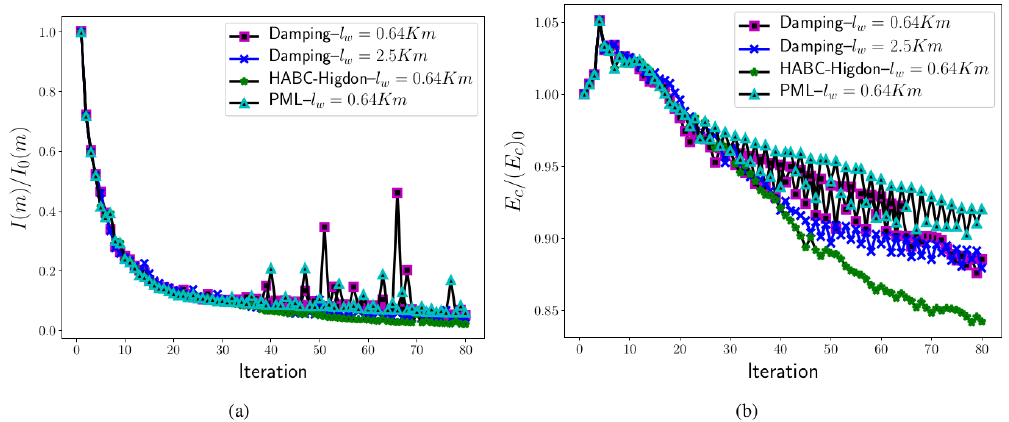
Figure 15. Comparisons of the misfit values I(m)/I 0 (m) (a) and of the velocity model errors E c /(E c ) 0 (b) for a velocity model computation that is then matched with Marmousi, where I 0 (m) and (E c ) 0 are the values obtained at the first iteration.